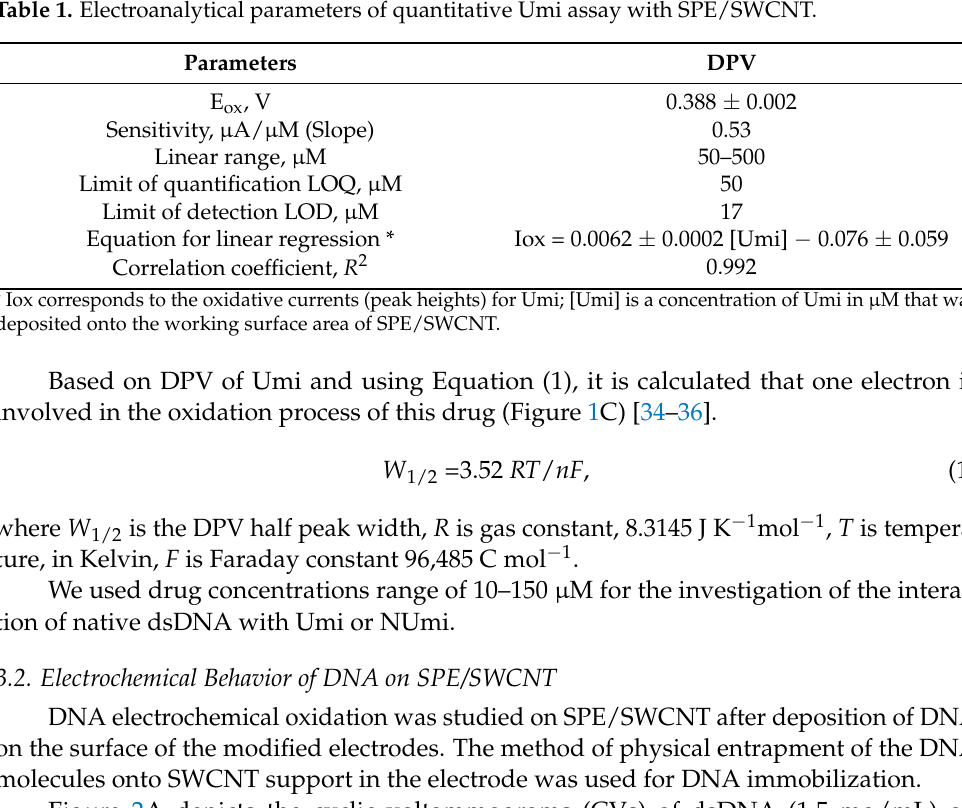
Table 1. Electroanalytical parameters of quantitative Umi assay with SPE/SWCNT Parameters